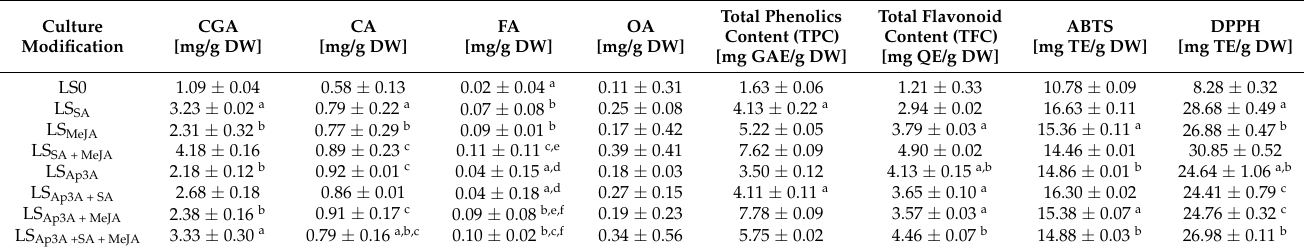
Table 2. The content of phenolic compounds and oleanolic acid in methanolic extracts from shoots Polyscias filicifolia growing under various culture conditions and their antioxidant